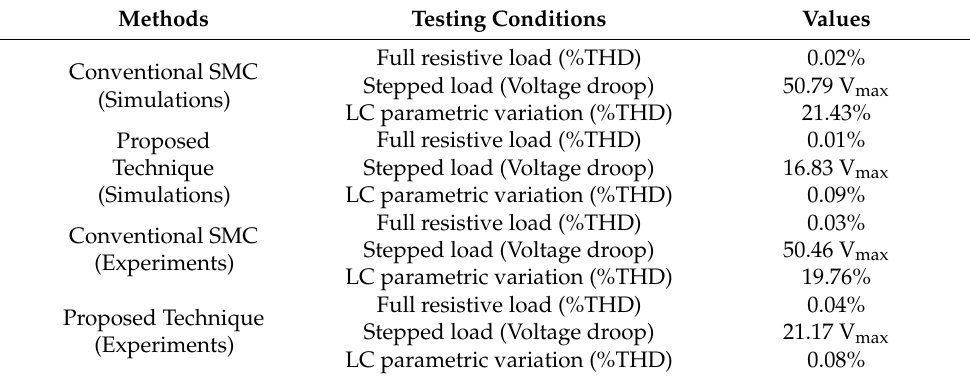
Table 2. Simulated and experimental voltage droop and %THD.